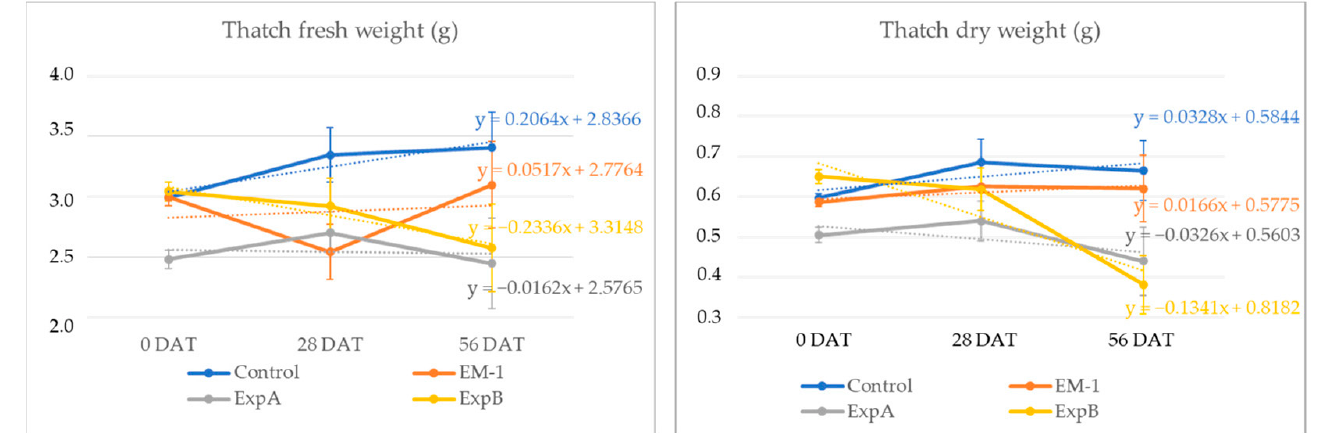
Figure 4. Changes in thatch fresh weight and thatch dry weight from 0 DAT to 56 DAT with the untreated control, EM-1, ExpA and ExpB.